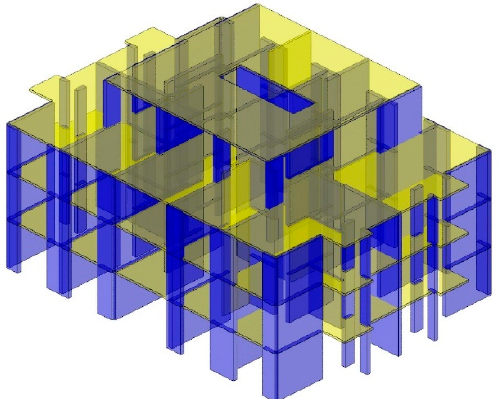
Figure 10. Numerical model for the case study building (isometric view).